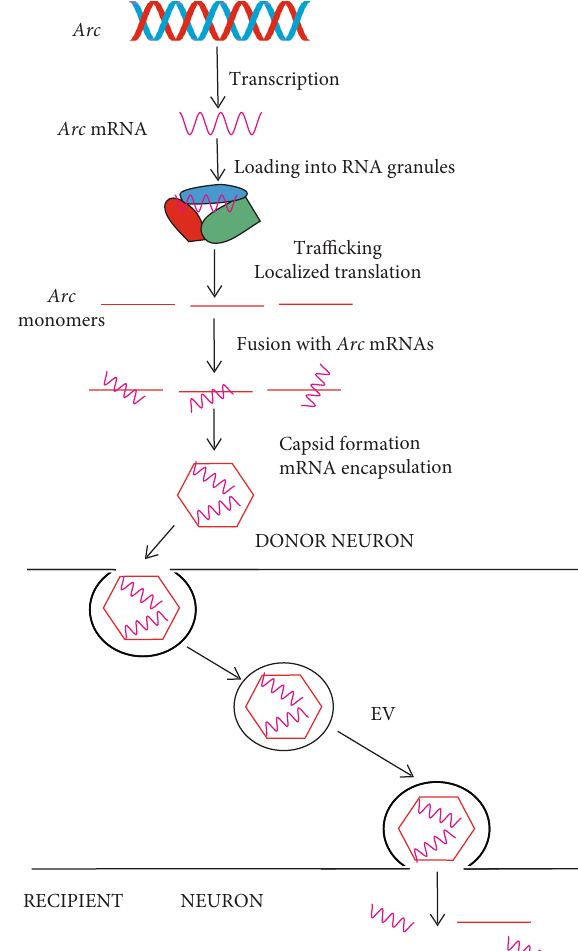
Figure 4: Interneuron transport of activity-regulated cytoskeleton- associated protein (Arc) and its mRNA. Transcription of the Arc gene produces Arc mRNA, which is tra ffi cked to dendrites in RNA granules and translated in response to synaptic activity, resulting in a high local concentration of the Arc protein (red bar), which may oligomerize to form a capsid encapsulating Arc mRNAs. Arc capsid with loaded Arc mRNA departs from the dendrite in extracellular vesicles (EVs) and may be endocytosed by dendrites of di ff erent neurons. This may change synaptic activity in response to synaptic activation in another neuron. This fi gure is limited to Arc mRNA, but RNA granules may contain a selection of di ff erent RNAs, and Arc capsids may encapsulate di ff erent RNA species and other putative factors. Such transfer was also shown between neurons and muscle